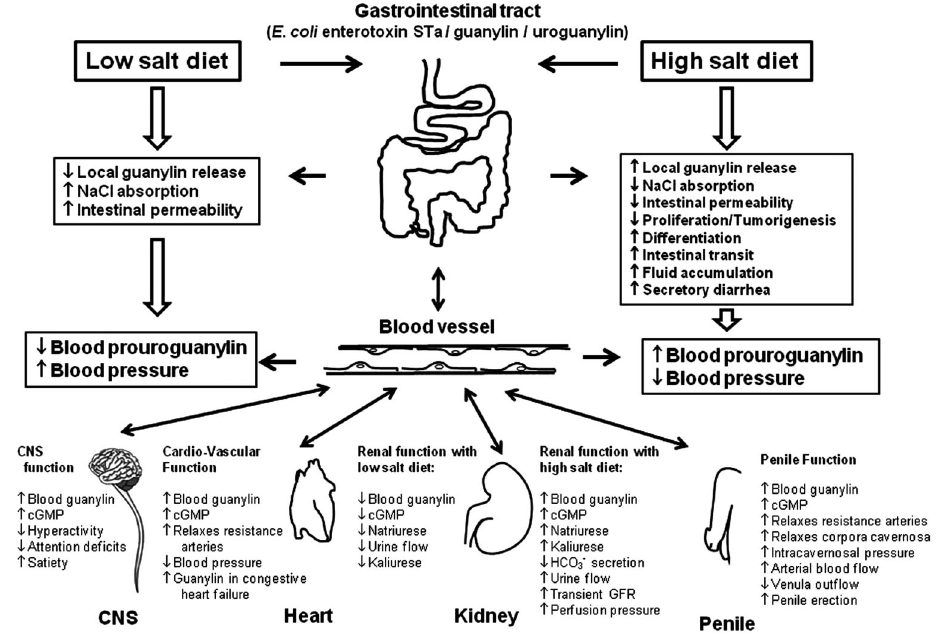
Figure 3. Major physiological functions associated with the heat-stable enterotoxin (Sta) from Escherichia coli , guanylin, and uroguanylin in guanylate cyclase C (GC-C) signaling pathways. GC-C is expressed on the surface of the intestinal epithelial cells where it is activated by the STa enterotoxin from E. coli and by the endogenous hormones guanylin and uroguanylin. These endogenous hormones are synthesized in the intestine and secreted into the lumen and blood circulation. GC-C is also a receptor for these peptides that activates the catalytic portion of this protein, resulting in the conversion of guanosine triphosphate to cyclic-guanosine-3 9 , 5 9 -monophosphate (cGMP). Increased cGMP concentration activates protein kinase GII, which phosphorylates and activates the cystic fibrosis transmembrane conductance regulator, leading to chloride/bicarbonate secretion. In addition, cGMP inhibits the sodium- hydrogen exchanger NHE3, decreasing sodium absorption. Local intestinal secretion of guanylin and uroguanylin co-regulates via GC- C signaling the homeostasis of the crypt-villus axis as well as intestinal barrier function and mechanisms underlying colorectal cancer. High or low salt diets co-regulate local intestinal secretion or systemic circulation of these endogenous hormones, which results in electrolyte and water homeostasis influenced by their effects on the gastrointestinal and urinary tracts. The blood circulation of guanylin and uroguanylin alters the functions of several other systems such as the central nervous system (CNS), cardiovascular system, kidney function, and penile function (see text for further